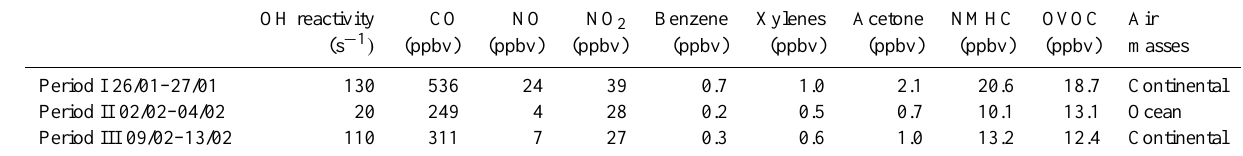
Table 3. Mean values of the main pollution compounds measured during period I, II and